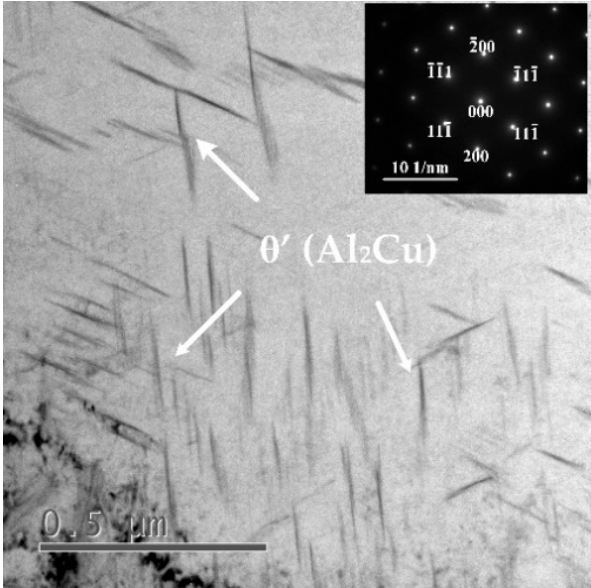
Figure 5. The TEM morphology of θ′ (Al 2 Cu) precipitates along <101> direction of α -Al matrix.